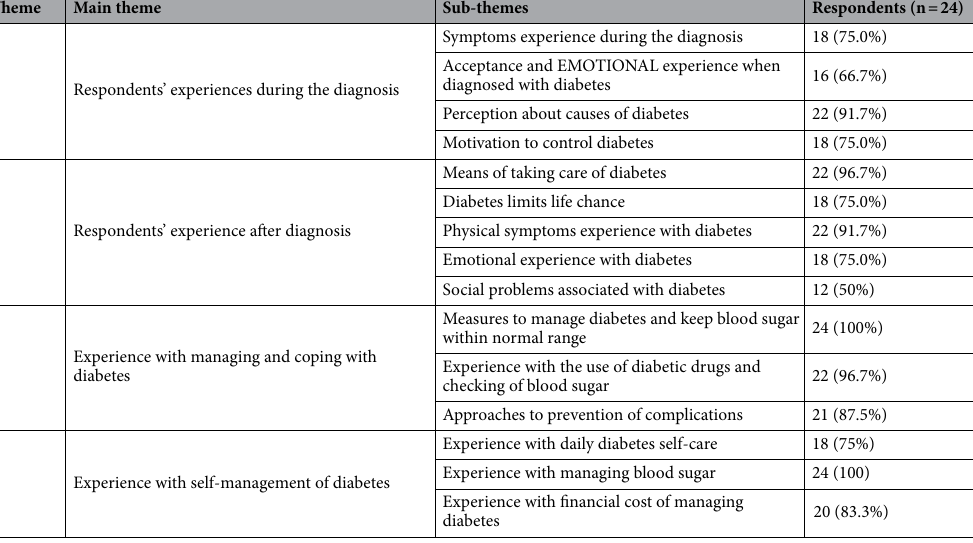
Table 6. Main themes and subthemes generated from